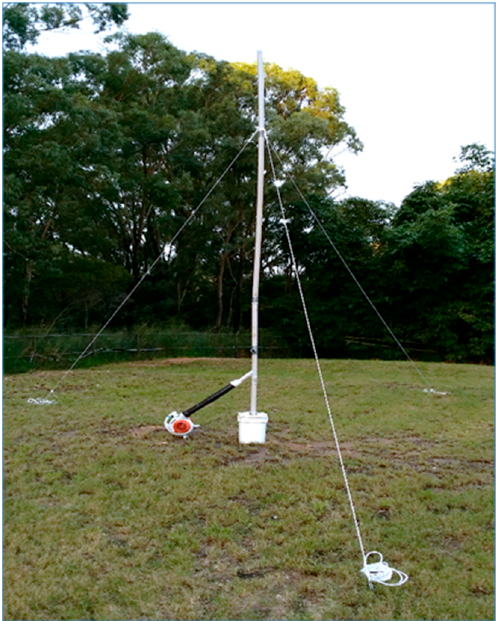
Figure 14. Powder ejection system setup.